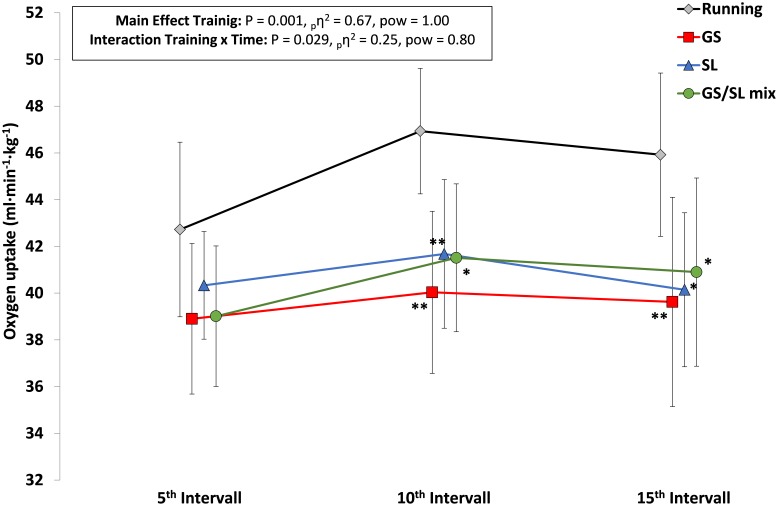
Peak VO2 values within interval 1–5 (5th interval), 6–10 (10th interval), and 11–15 (15th interval) for the four HIT protocols with running, giant slalom mode (GS), slalom mode (SL), and the mixed GS/SL mode. ∗P < 0.05, ∗∗P < 0.01, significant different to running; pη2, partial eta square effect size; pow, statistical power; and mean ± SD.